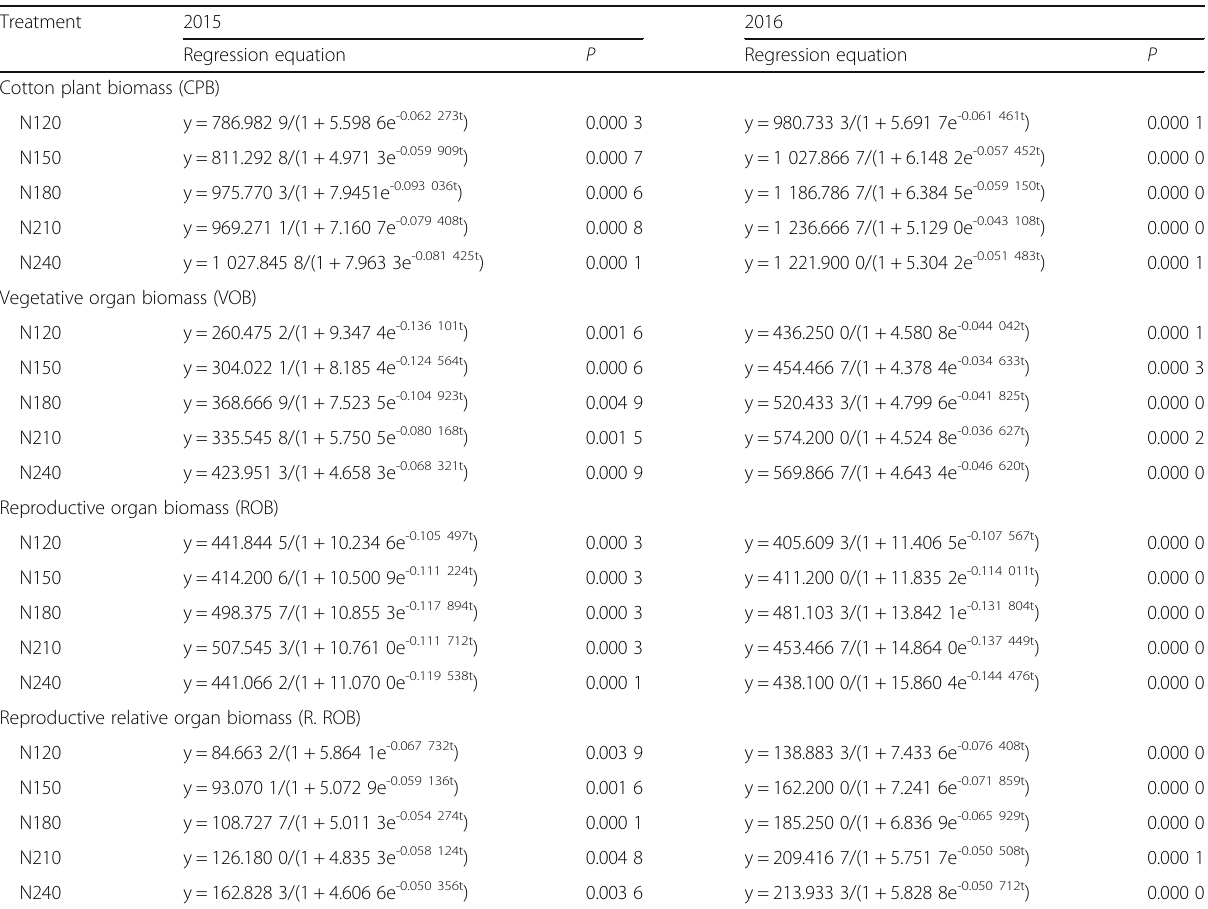
Table 3 Regression equations of cotton plant biomass accumulation in the field affected by different N rates in 2015 and 2016